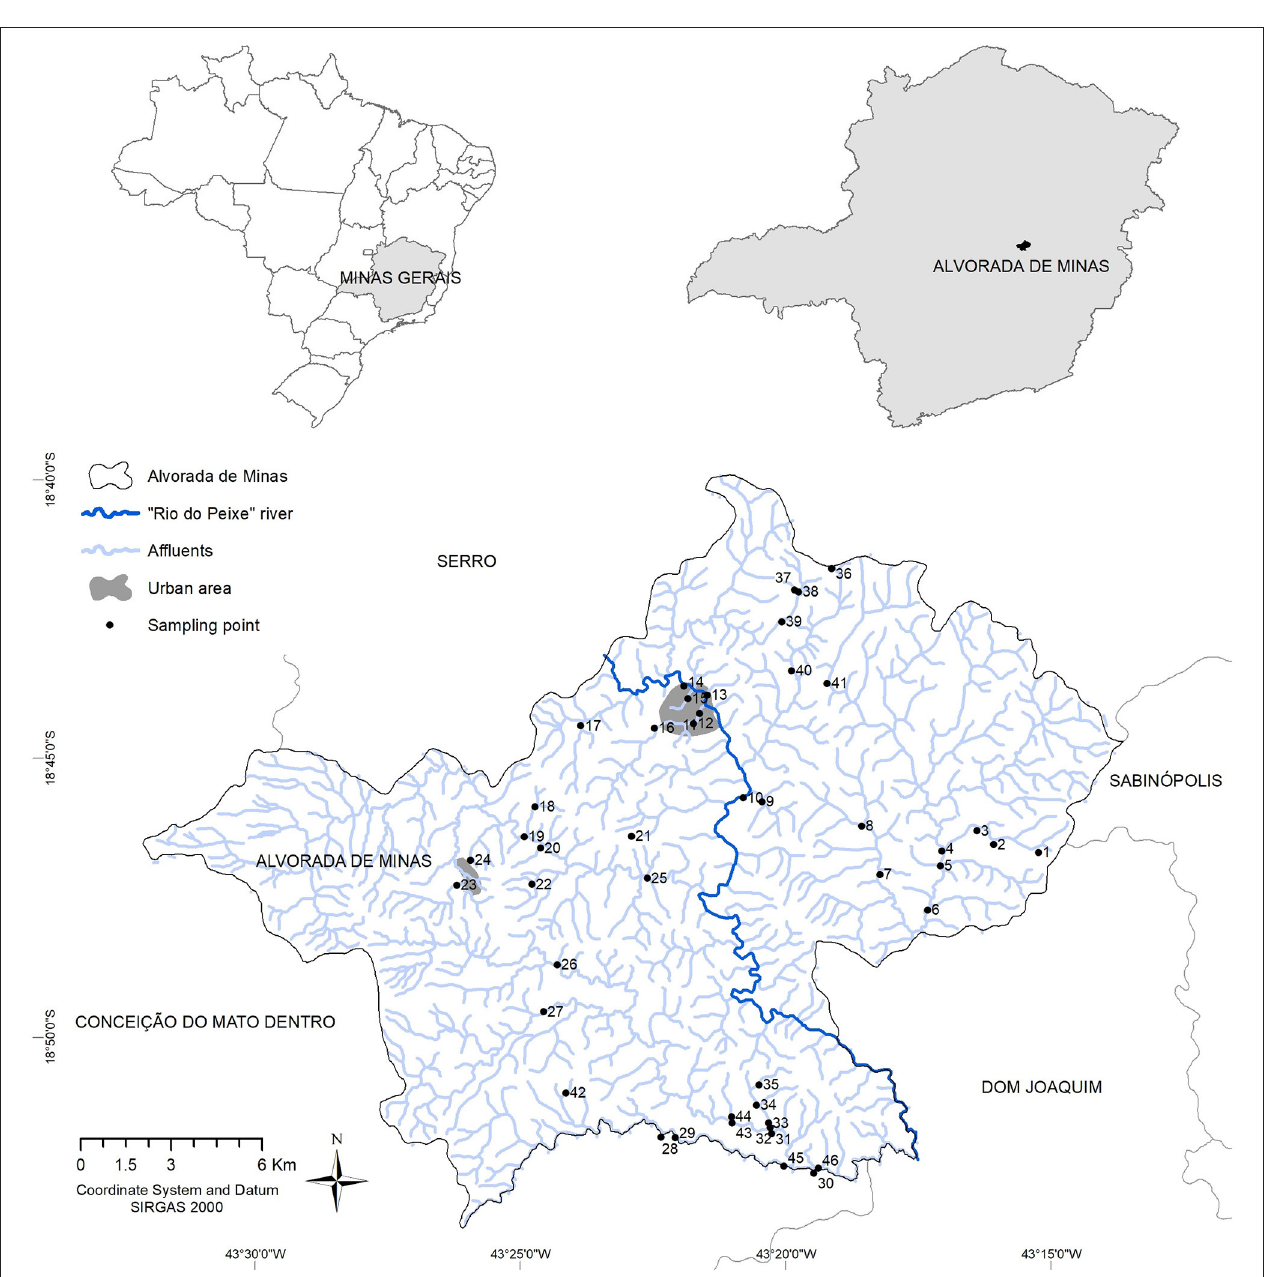
FIGURE 1 | Distribution of water resources and the 46 collection points for the investigation of limnic molluscs, between the years 2018 and 2019, in the Municipality of Alvorada de Minas, Minas Gerais,